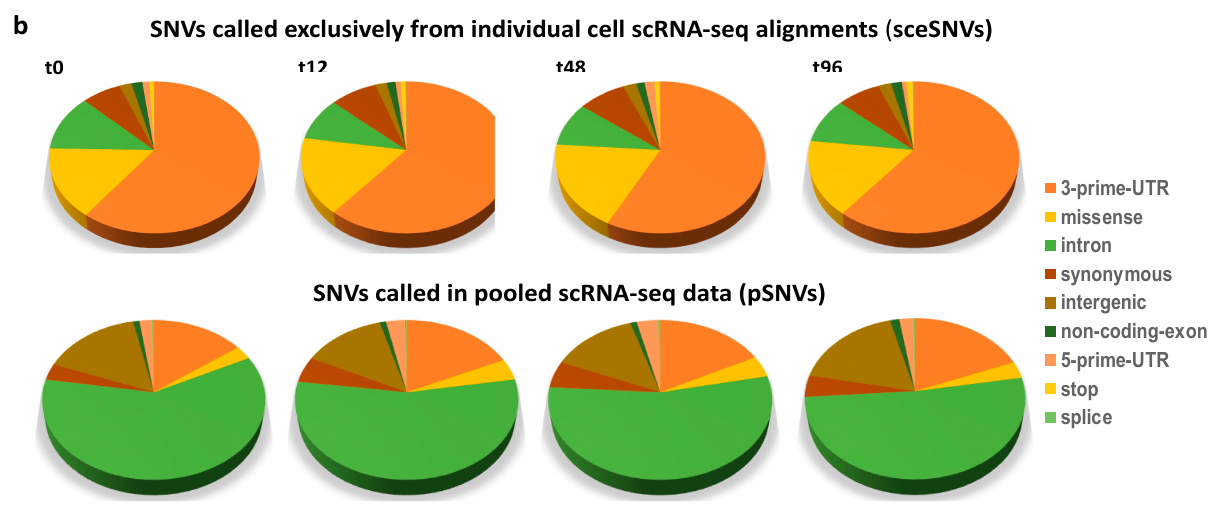
Figure 3. ( a ). Percentage of novel and known SNVs called exclusively in the individual alignments (sceSNVs, top) and in the pooled scRNA-seq data (pSNVs, bottom). An approximately 5-fold higher percentage of novel SNVs was seen in the individual cell alignments. ( b ). Distribution of functional annotations among the SNVs called exclusively in the individual alignments (top), as compared to the pooled scRNA-seq data (bottom). Significantly higher proportions of 3’-prime-UTR, missense and stop-codon SNVs were called in the individual alignments.